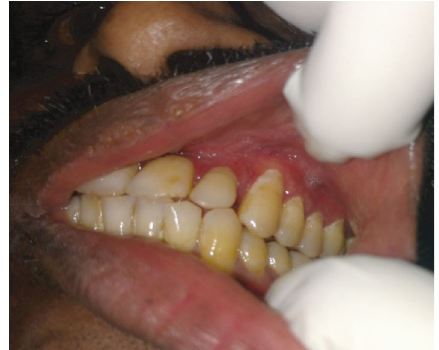
Figure 2: Evidence of erythema of the attached gingiva in relation to maxillary posterior teeth. The clinical features resembled a periodontal